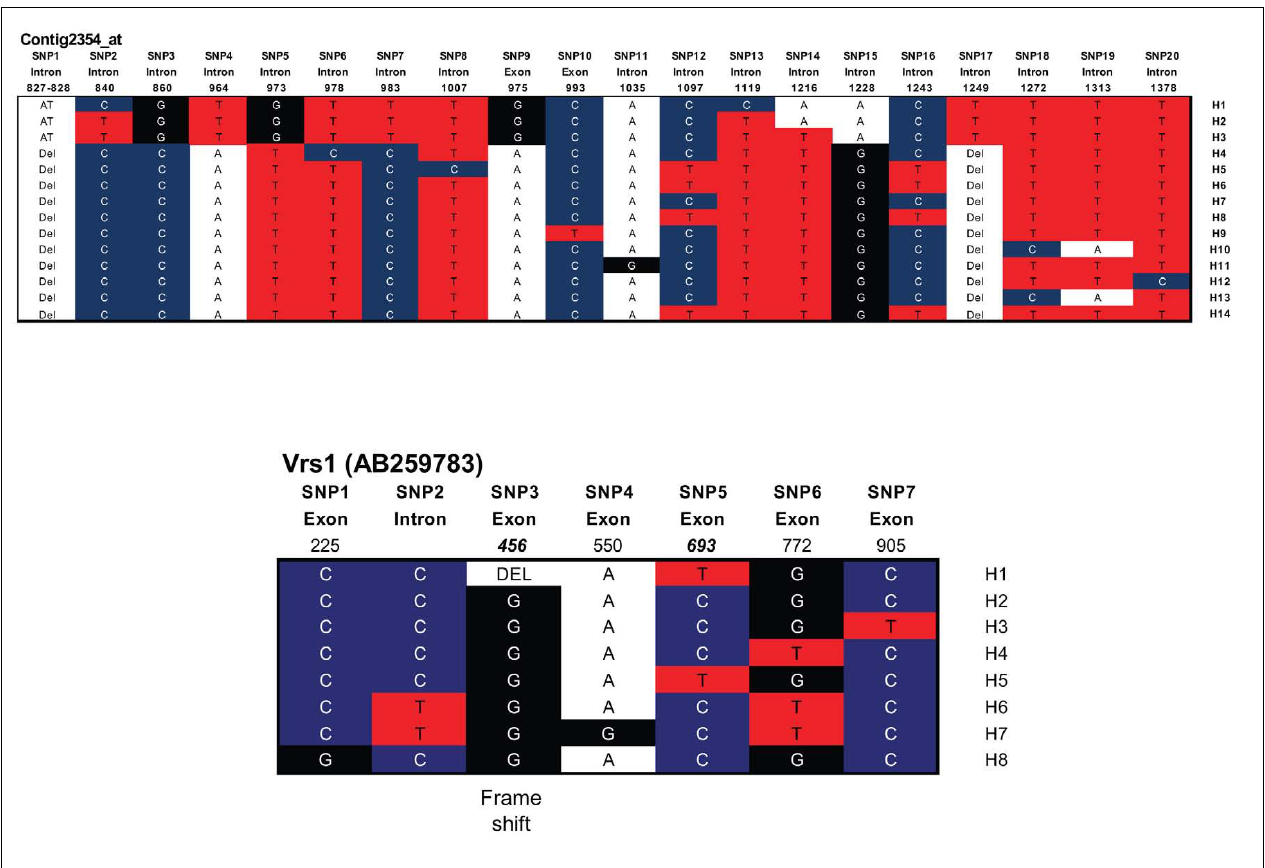
of CGs are shown below tables. Vrs1 Is shown as example of the gene most significantly associated with row number. H1–H14, haplotypes Nr. 1–14 per CG.